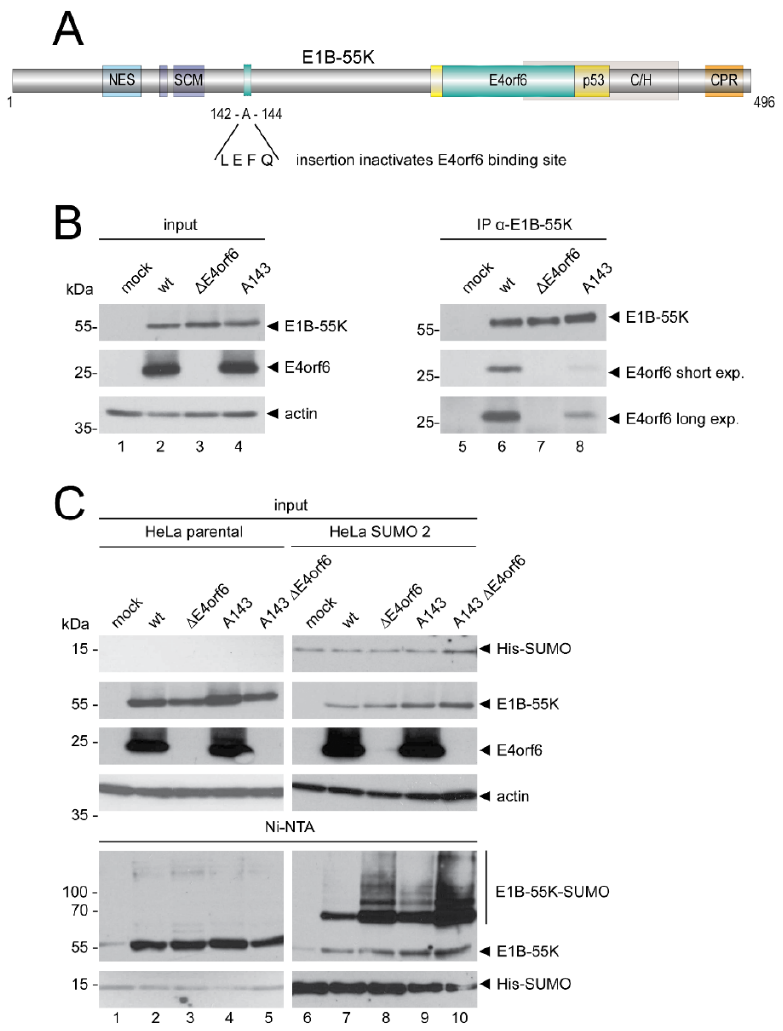
Figure 4. Abrogation of the interaction between E1B-55K and E4orf6 strongly increases E1B-55K SUMOylation. ( A ) Schematic overview of the HAdV-C5 E1B-55K protein. The E4orf6 binding mutant A143 with leucine (L), glutamic acid (E), phenylalanine (F), and glutamine (Q) insertions at position A143, which abrogates E4orf6 binding. NES, nuclear export signal. SCM, SUMO conjugation motif. The turquoise E4orf6- and the yellow p53-boxes indicate the respective essential binding regions of these proteins to E1B-55K. C/H, conserved histidine (H) and cysteine (C)-rich zinc finger binding domain. CPR, C-terminal phosphorylation region. Amino acid positions are indicated. ( B ) A549 cells were infected with HAdV-C5 wt and the indicated virus mutants at an MOI of 20 and harvested at 24 h p.i. Whole cell extracts were prepared for E1B-55K immunoprecipitation (IP) using the 2A6 mouse mAb. Proteins were separated by SDS-PAGE and subjected to Western blotting. ( C ) Parental HeLa cells or HeLa cells that constitutively express His-tagged SUMO 2 were mock infected or infected with indicated viruses at an MOI of 20. Cells were harvested at 24 h p.i, total cell lysates prepared, and His-SUMO conjugates were Ni-NTA purified. Proteins were separated by SDS-PAGE according to their molecular weight and subjected to Western blotting. Proteins were detected using mAb AC-15 (actin), mAb 2A6 (E1B-55K), mAb RSA3 (E4orf6), and mAb 6×His (SUMO 1/2) in Western blot analysis. Molecular weights in kDa are indicated on the left, while corresponding proteins are labeled on the right. Images represent the results of >3 repeated experiments.